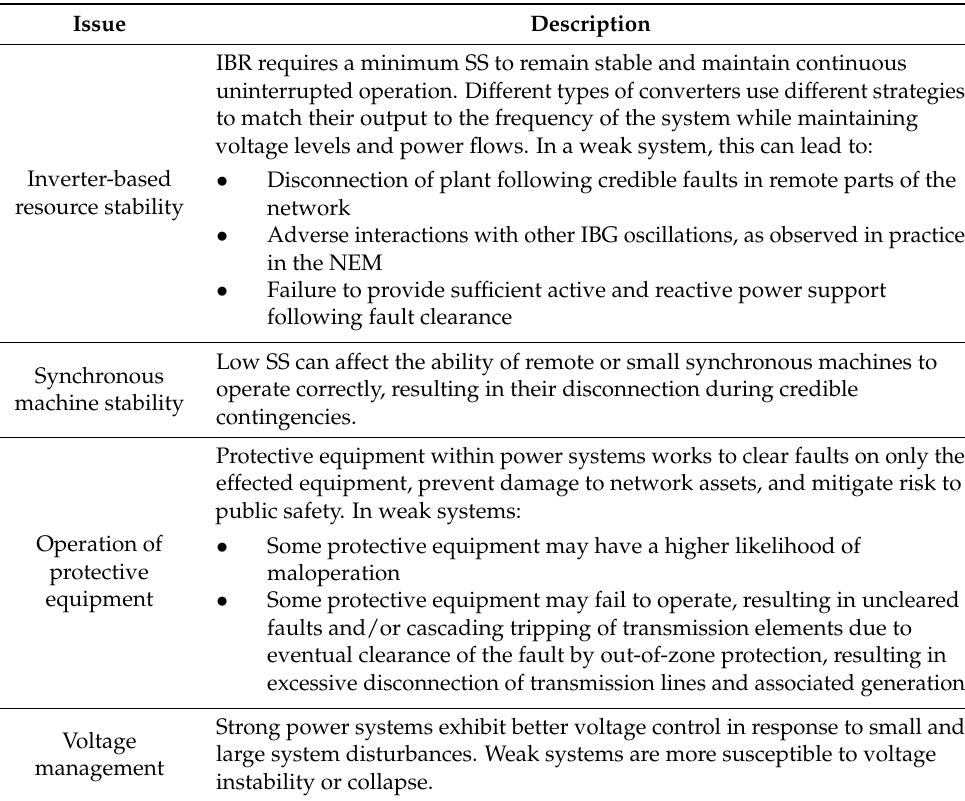
Table 1. Summary of Main Issues Associated with Weak Grid